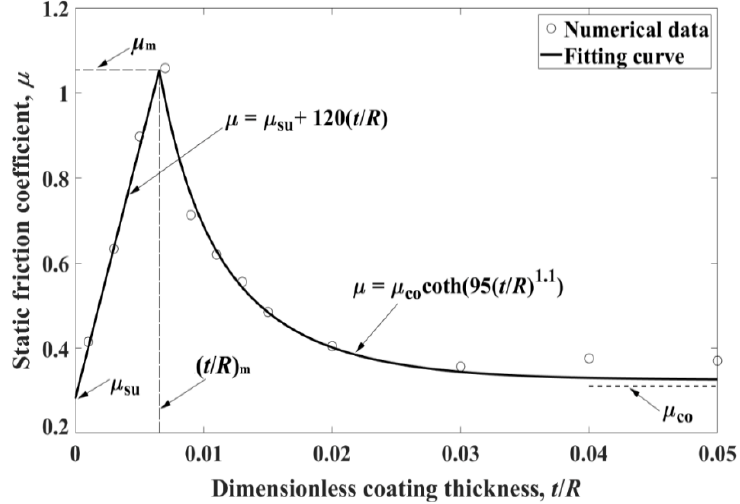
Figure 6. Typical behavior of the static friction coe ffi cient µ as a function of t / R , taken from [43].